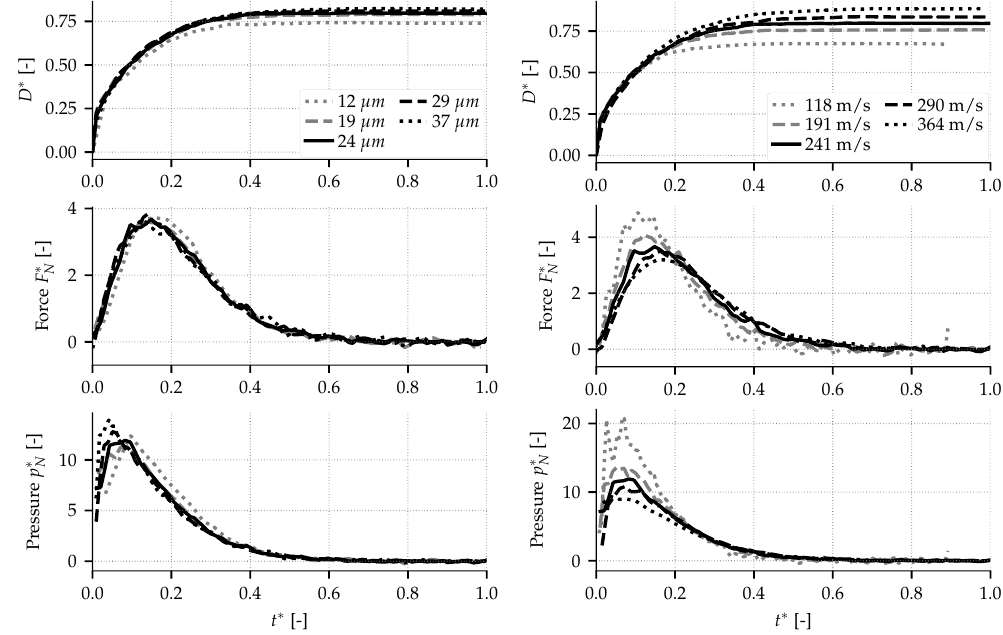
Figure 8. Influence of the initial sand particle diameter ( left ) and normal velocity ( right ) on the impact transients in the nondimensional spreading diameter ( top ), total normal force ( middle ) and contact pressure ( bottom ) as a function of nondimensional